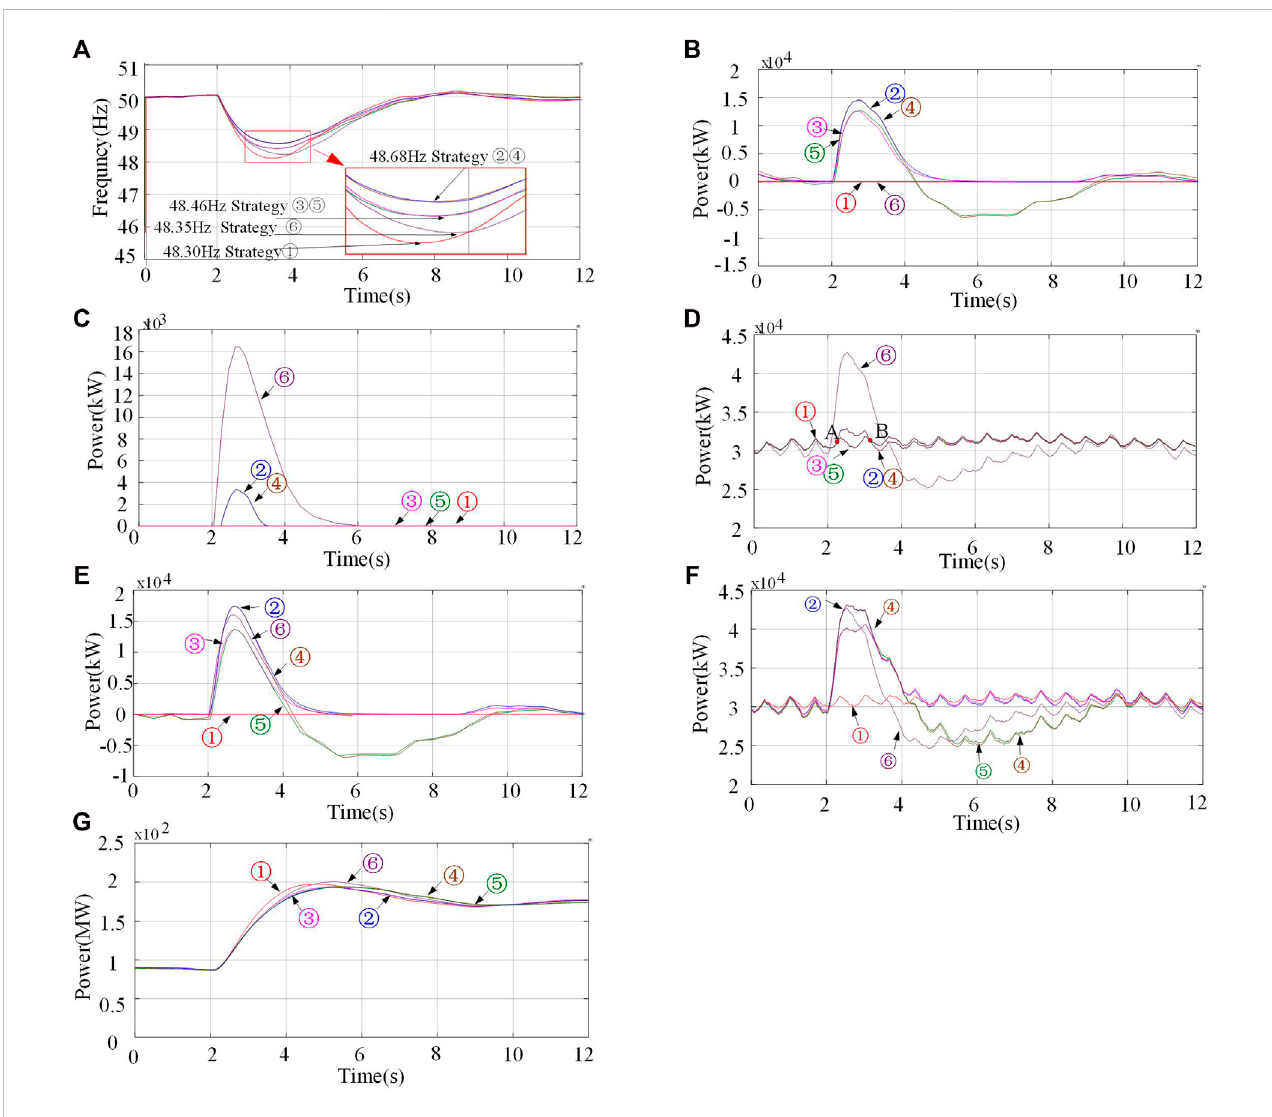
FIGURE 11 The simulation